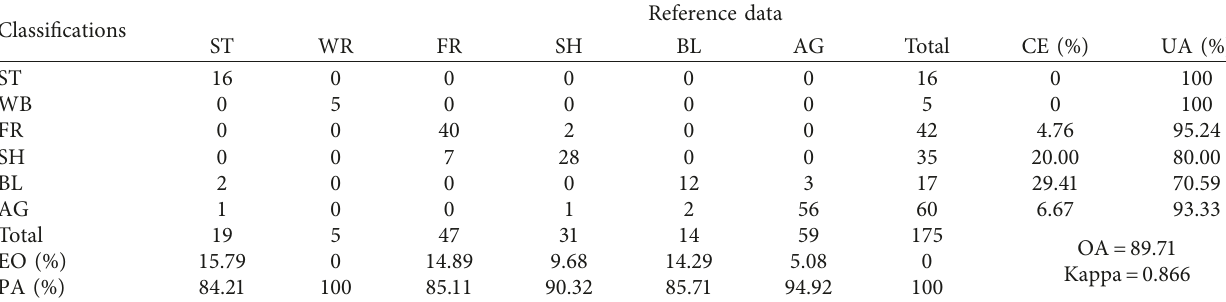
Table 5: Confusion matrix accuracy for the classification of 2017.